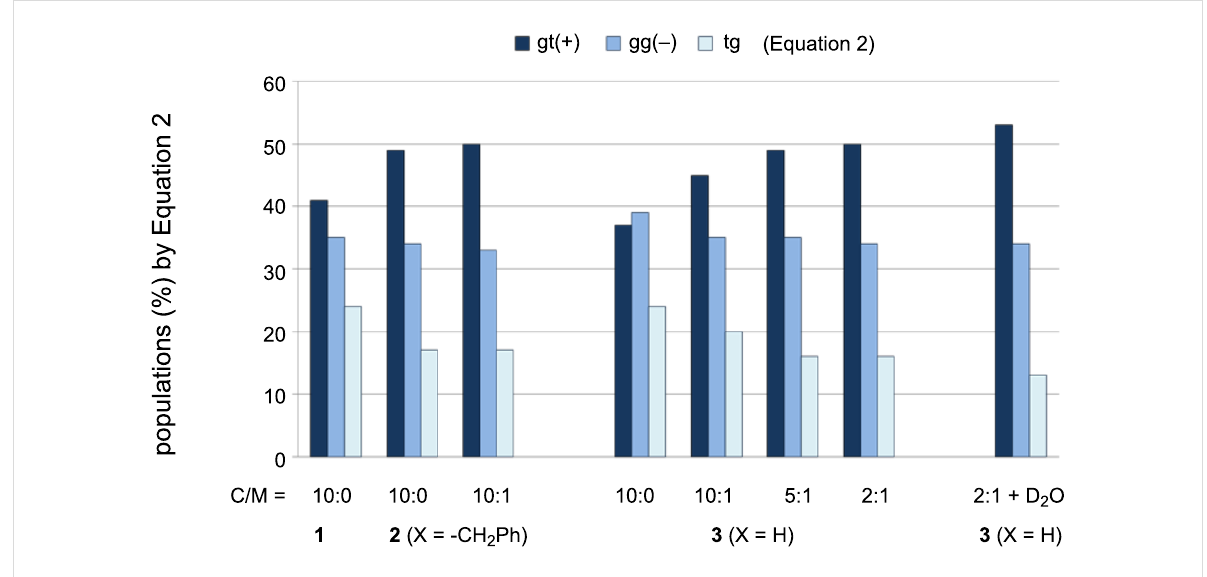
Figure 3: Fractional populations (%) of the three staggered conformers around the sn -1,2 C–C single bond in 1,2-dipalmitoyl- sn -glycerols 1 – 3 bear- ing different substituents (X) at the sn -3 position. Populations (%) are calculated from Equation 2 and each of the populations possibly includes devia- tions within ±3% by digital resolution (<0.12 Hz) of 1 H NMR spectroscopy (500